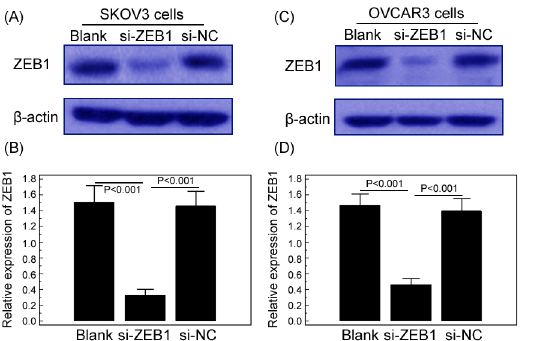
Figure 4. Down-regulation of Zinc Finger E-Box Binding Homeobox 1 (ZEB1) by siRNA interference. Western blot analysis was performed to detect the expression levels of ZEB1 protein in siRNA- ZEB1 transfected, siRNA-NC transfected and non-transfected (blank) SKOV3 (A and B) and OVCAR3 (C and D) cells. b -actin was used as an internal loading control.